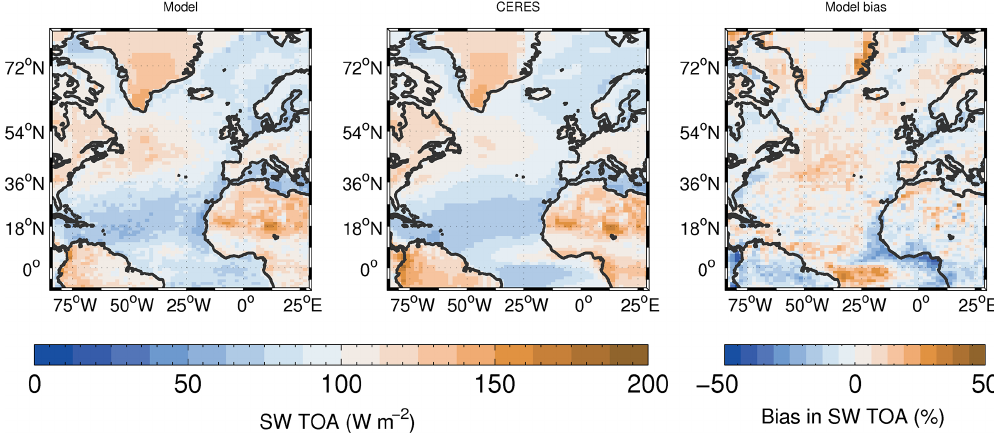
Figure 8. Time-mean model SW TOA evaluation vs. the CERES satellite. The monthly mean CERES-EBAF data product is used here; this product uses data from both the Terra and Aqua satellites as well as geostationary satellites in order to approximate averaging across the diurnal cycle. The arrangement of the panels is as for Fig. 1.